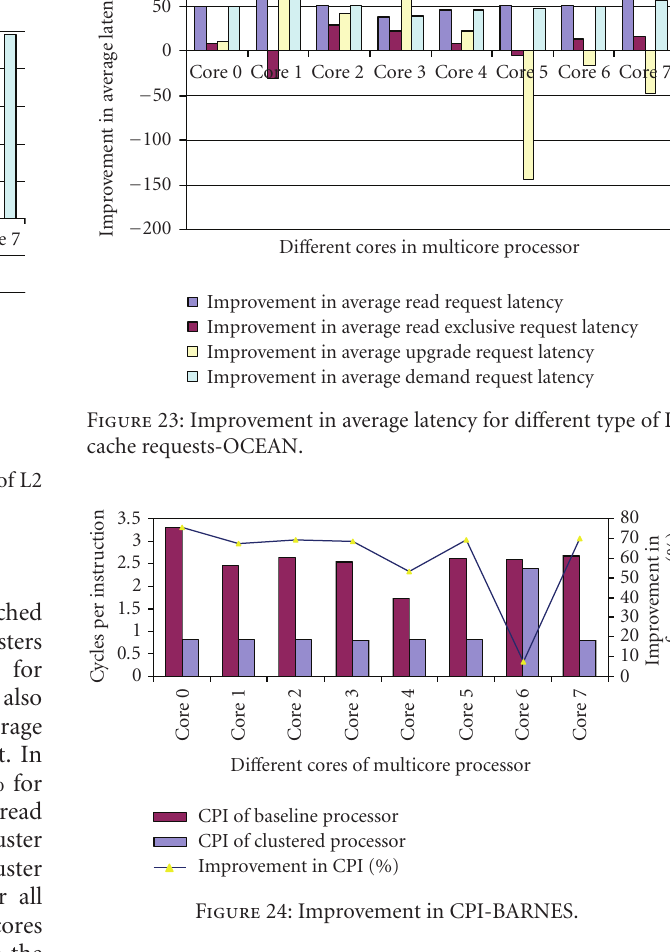
Figure 24: Improvement in